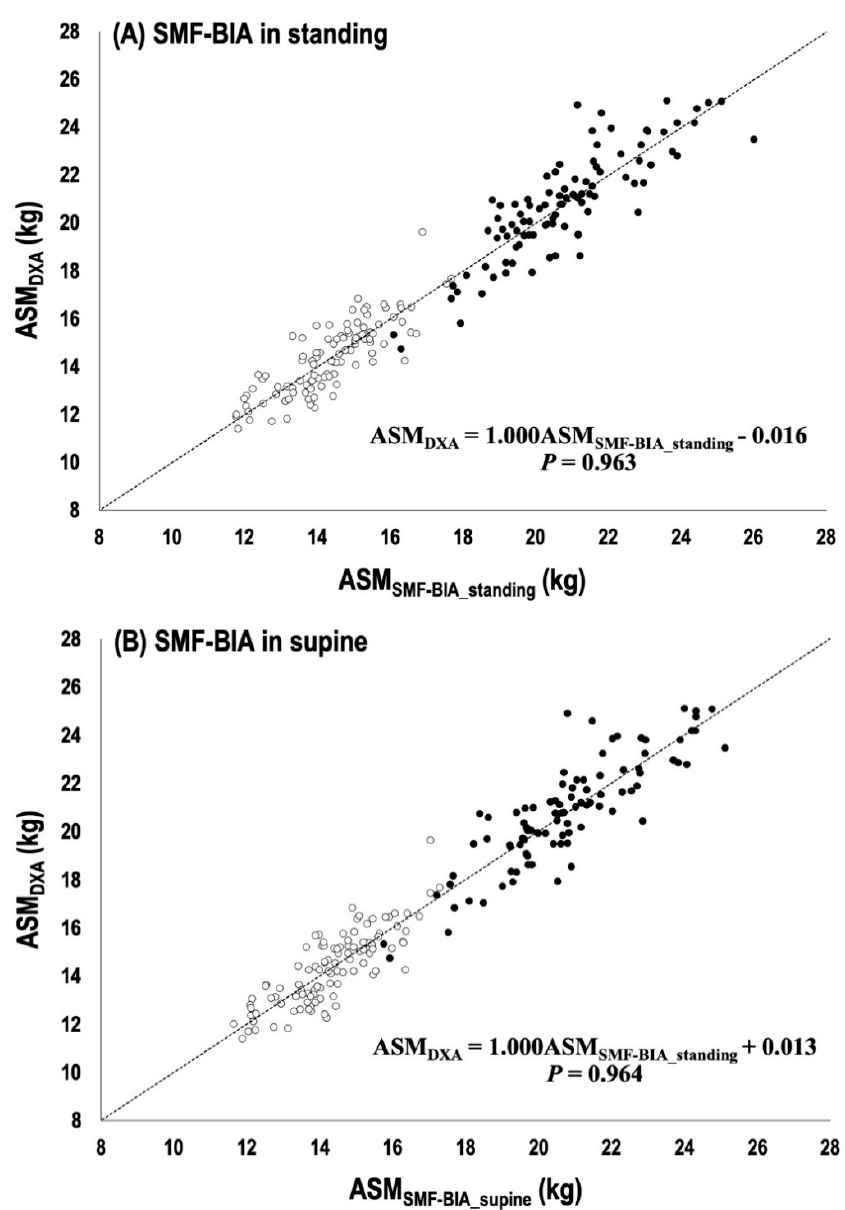
Figure 2. Bivariate regression analysis; ( A ) The line of best fit and standard error of estimate for the standing BIA prediction equation ( B ) The line of best fit and standard error of estimate for the supine BIA prediction. BIA